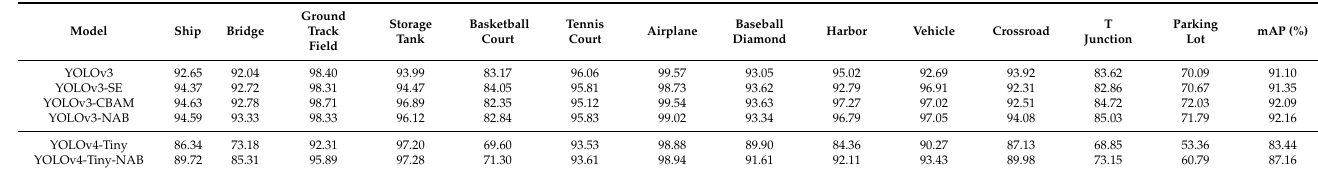
Table 3. Detection results on TGRS-HRRSD.